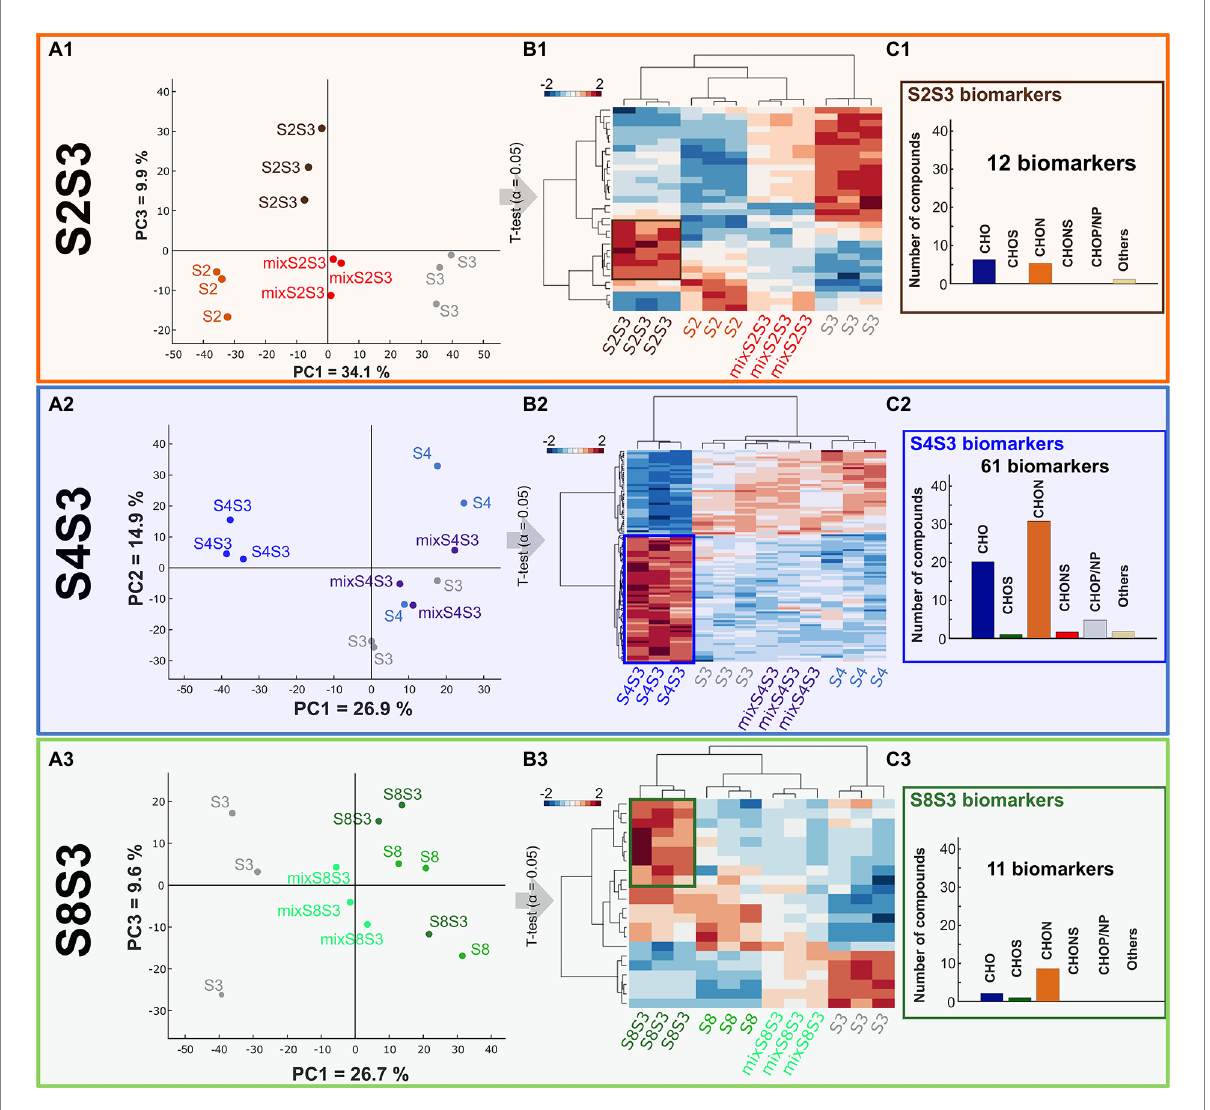
FIGURE 5 Impact of cocultures on chemical composition. UPLC-q-ToF-MS data (A) PCA of data of pure cultures, coculture and post-alcoholic single fermentation Chardonnay wine mixes for each modality S2S3 (orange), S4S3 (blue), S8S3 (green). (B) HCA representing extracted significantly different compounds, assessed by t -test (value of p < 0.05), in pure cultures, cocultures and mixes. (C) Histogram proportions of elemental compositions of significantly more intense biomarkers of each